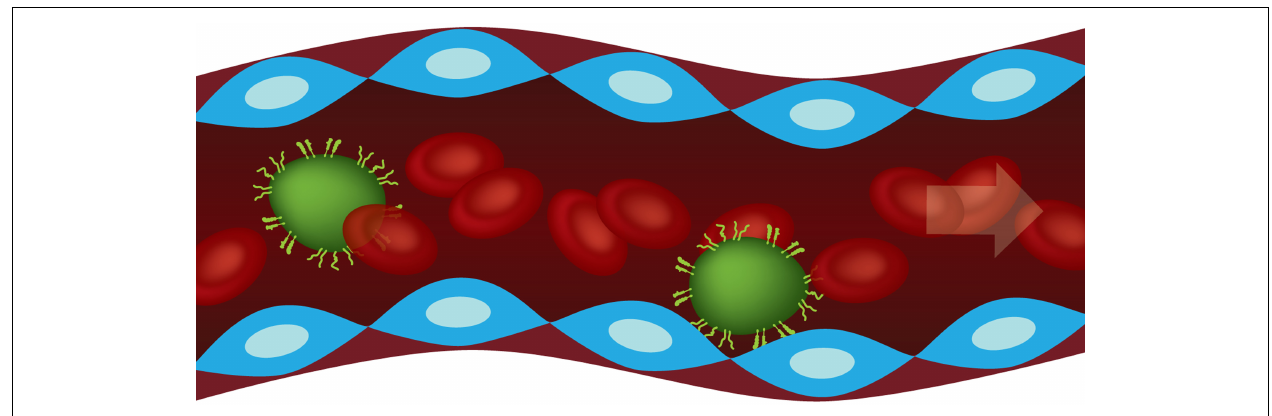
FIGURE 1 | Schematic representation of circulating tumor cells (CTCs in green) transported by the blood flow and tethering the endothelial cells (blue) through ligand molecules.